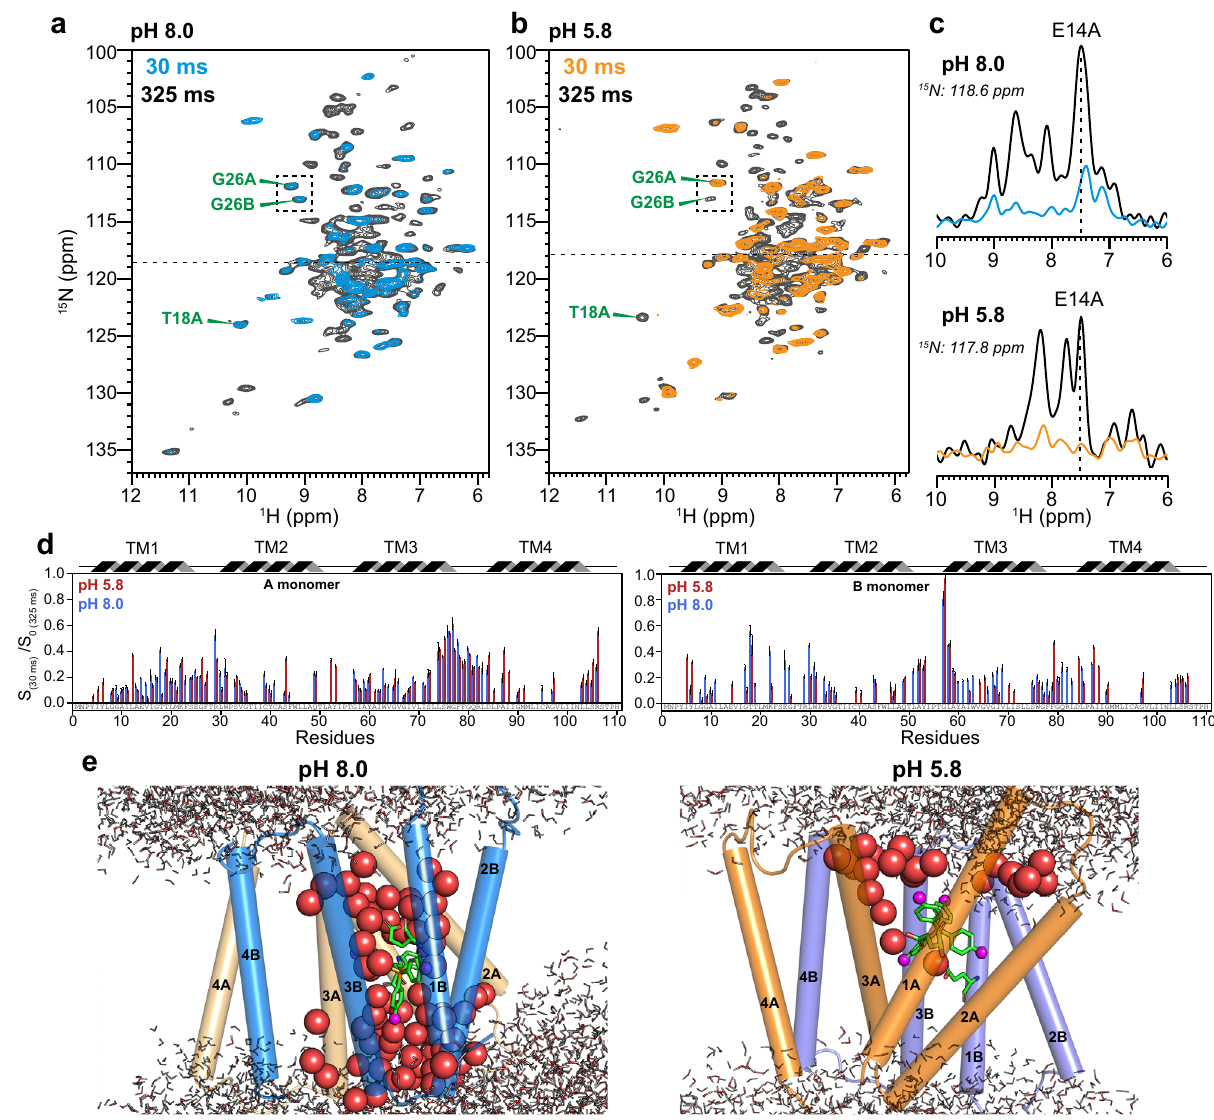
Fig. 6 Water-edited 2D hNH spectra of TPP + -bound EmrE. a pH 8.0 spectra. b pH 5.8 spectra. c 1D 15 N cross-sections of E14A extracted from the water- edited 2D hNH spectra. The pH 8.0 sample shows higher water-transferred intensities than the pH 5.8 sample. d Intensity ratios S / S 0 between the 30 and 325 ms spectra of the water-edited 2D spectra to compare the water accessibilities between the high and low pH proteins. The intensities have been corrected for 1 H R 1 relaxation. e MD equilibrated membrane-bound structures of the EmrE-TPP + complex at pH 8.0 and pH 5.8. Water oxygens within 15 Å of any of the ligand atoms and that are within the lipid bilayer are shown as red spheres. Membrane-surface water molecules are shown as thin lines, and water molecules >15 Å away from the protein are shown in gray. The number of water molecules is 69 in the high-pH complex but only 23 in the low-pH complex, consistent with the higher water-transferred intensities of the protein at high pH. Moreover, water hydrates the ligand from both sides of the membrane in the high-pH complex, but only accesses the ligand from the periplasmic side in the low-pH complex. The water-edited intensities are provided as a Source Data fi